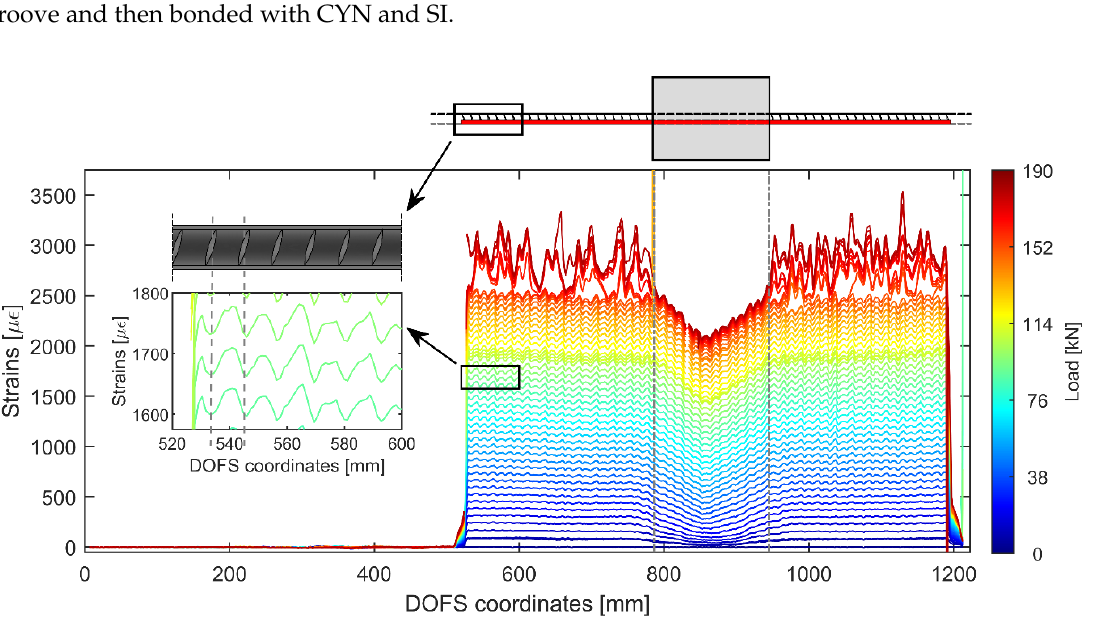
Figure 12. Three-dimensional representation of the strain evolution of member 15D20_21 with a zoom of the higher strains showing the progressive yielding of the different cross-sections of the rebar.